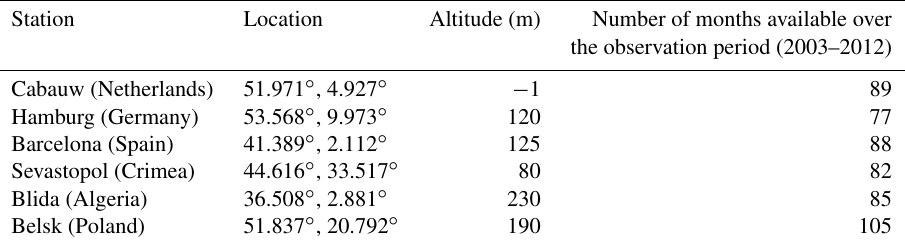
Table 1. Station name, location, altitude and number of months available over the observation period (2003–2012) of the six AERONET stations. Station Location Altitude (m) Number of months available over the observation period